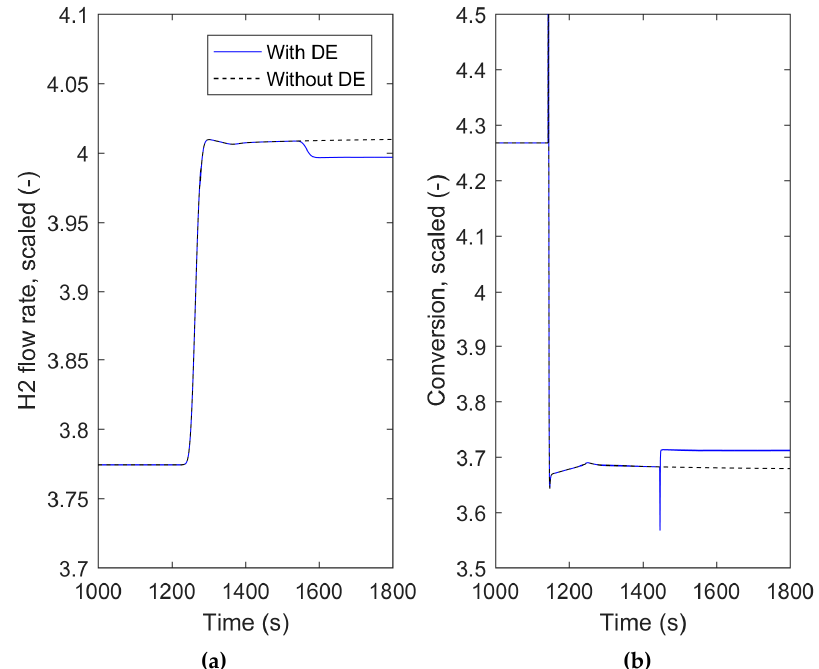
Figure 7. The hydrogen flow rate ( a ) and the conversion ( b ) behavior with and without the higher level optimization (DE). Step change to the hydrogen flow set-point at 1100 s. New optimized conversion value introduced to MPC at 1400 s.